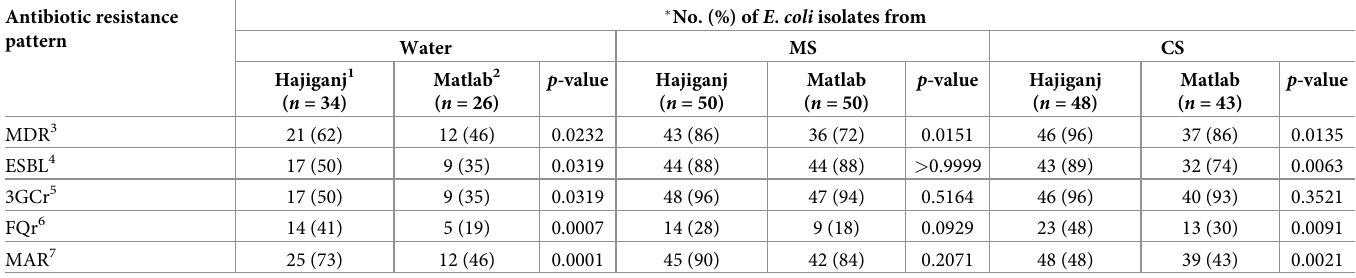
Table 2. Antibiotic susceptibility of E . coli isolates obtained from water, mother stool (MS), and child stool (CS) in Hajiganj and Matlab. Antibiotic resistance pattern